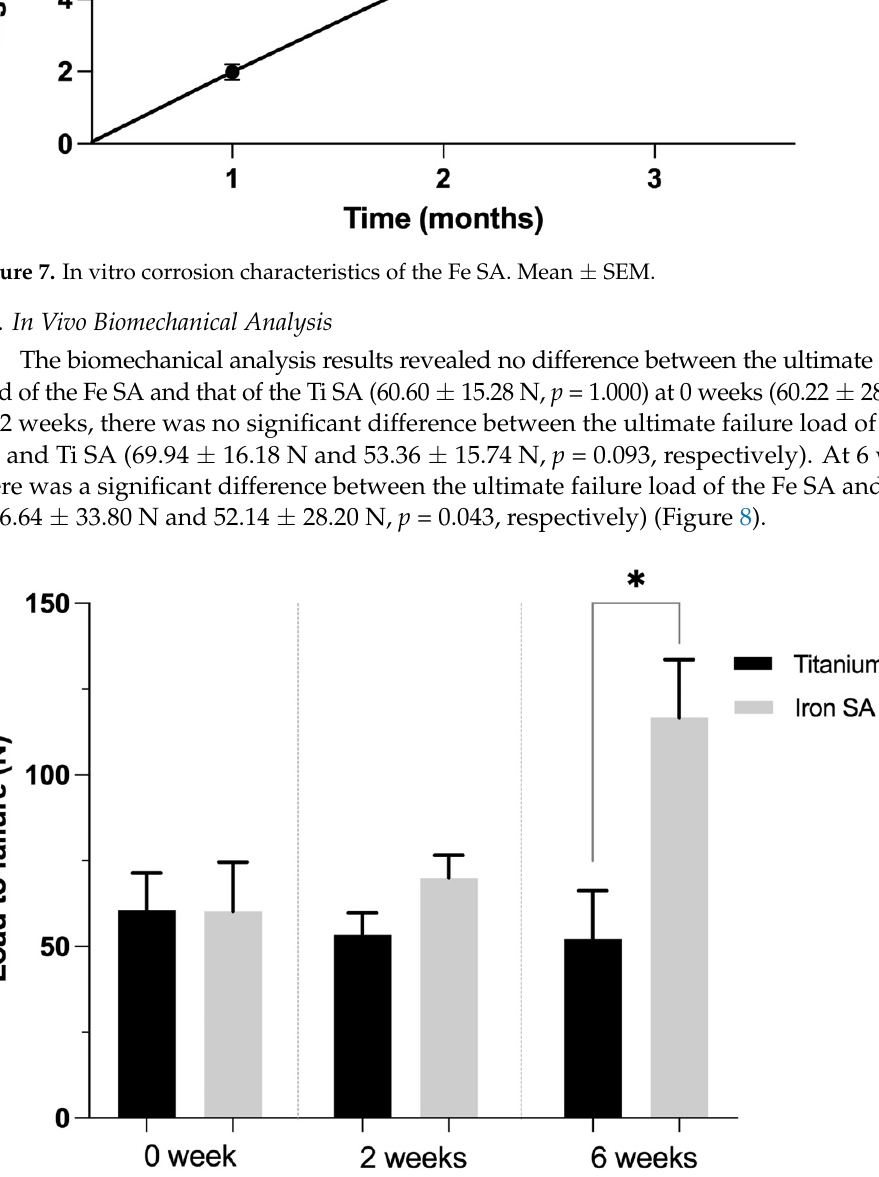
Figure 8. In vivo biomechanical ultimate pullout strength assessment for different SAs at 0, 2, and 6 weeks after surgery. Mean ± SEM. * p < 0.05.